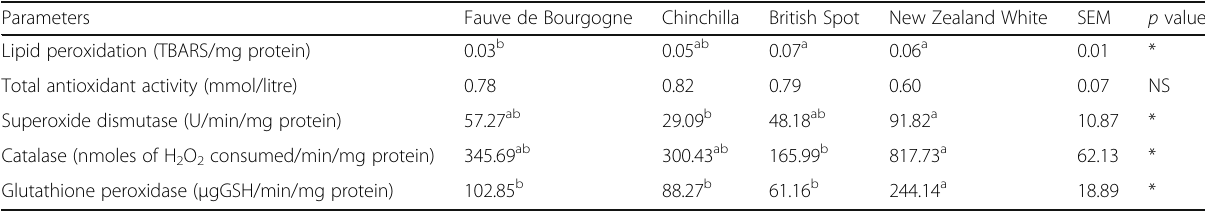
Table 3 Seminal oxidative status of four exotic breeds of rabbit